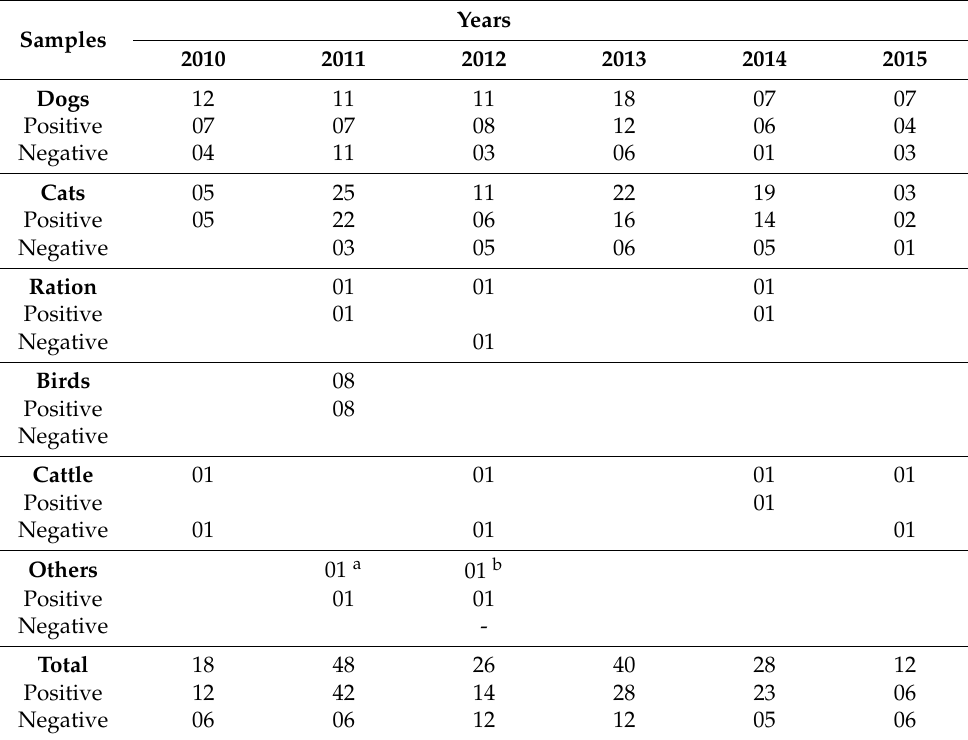
Table 19. Cases of suspected poisoning by carbamate pesticides (aldicarb and carbofuran) in animals whose tissue and feed samples were sent to the Laboratory of Toxicological Diagnosis (LADTOX) from 2010 to June 2015.